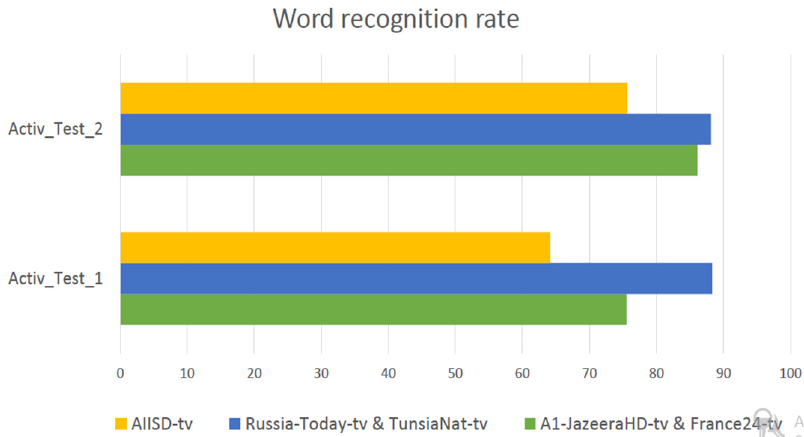
Figure 17. Comparison of proposed architecture with different architectures on word recognition rate (Activ dataset).